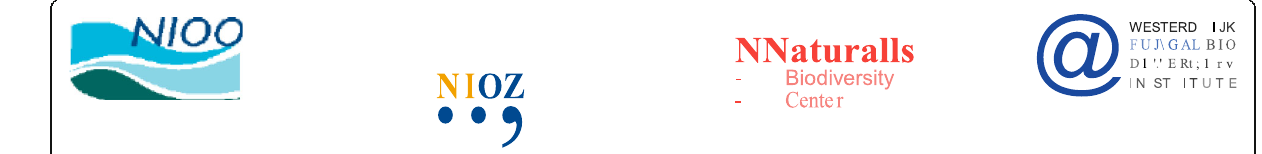
Fig. 11 Partners in the Centre of Excellence for Netherlands Biodiversity Research